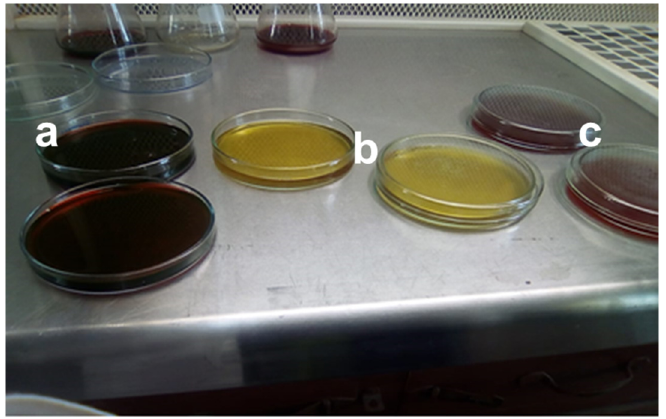
Figure 1. Different types of media ( a ) Eosin methylene blue (EMB) agar ( b ) Nutrient agar ( c ) Mac- Conkey agar. Conkey